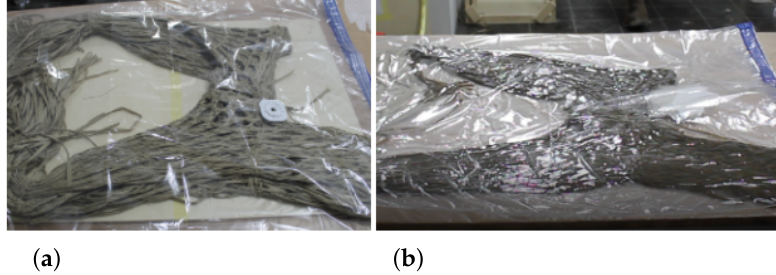
Figure 15. Vacuum resin infusion ( a ) Prior to resin infusion. ( b ) After resin